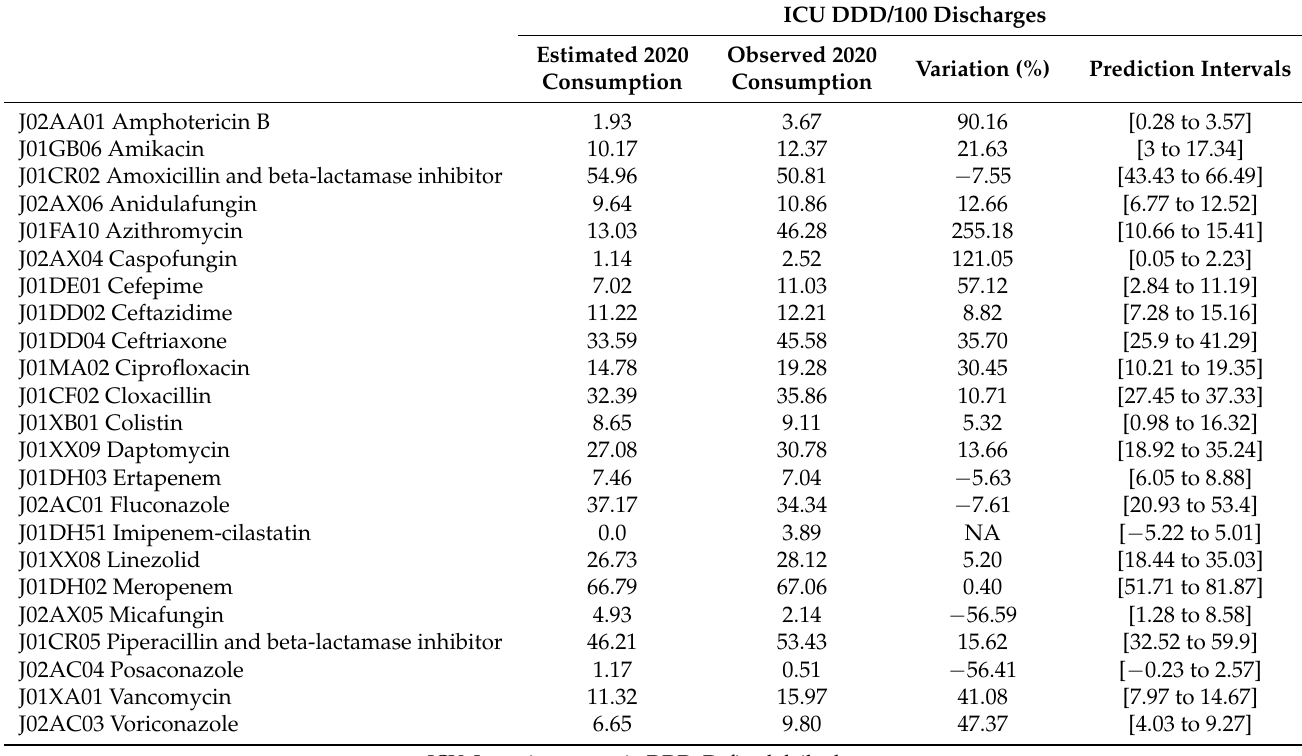
Table 3. Comparison between expected and observed intensive care unit (ICU) consumption, expressed in DDD/100 discharges. Estimated 2020 consumption was based on the trend from the non-COVID-19 period